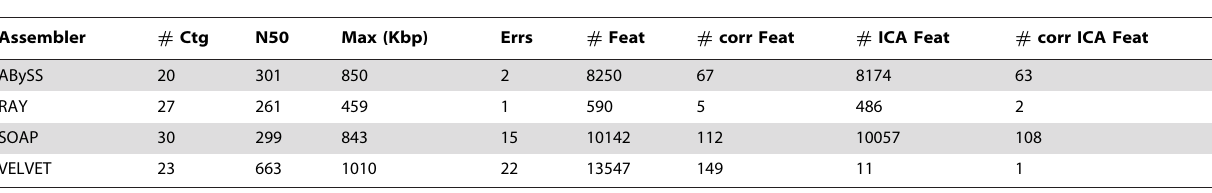
Table 5. Assembly Comparison Simulated Short Reads: Brucella suis.